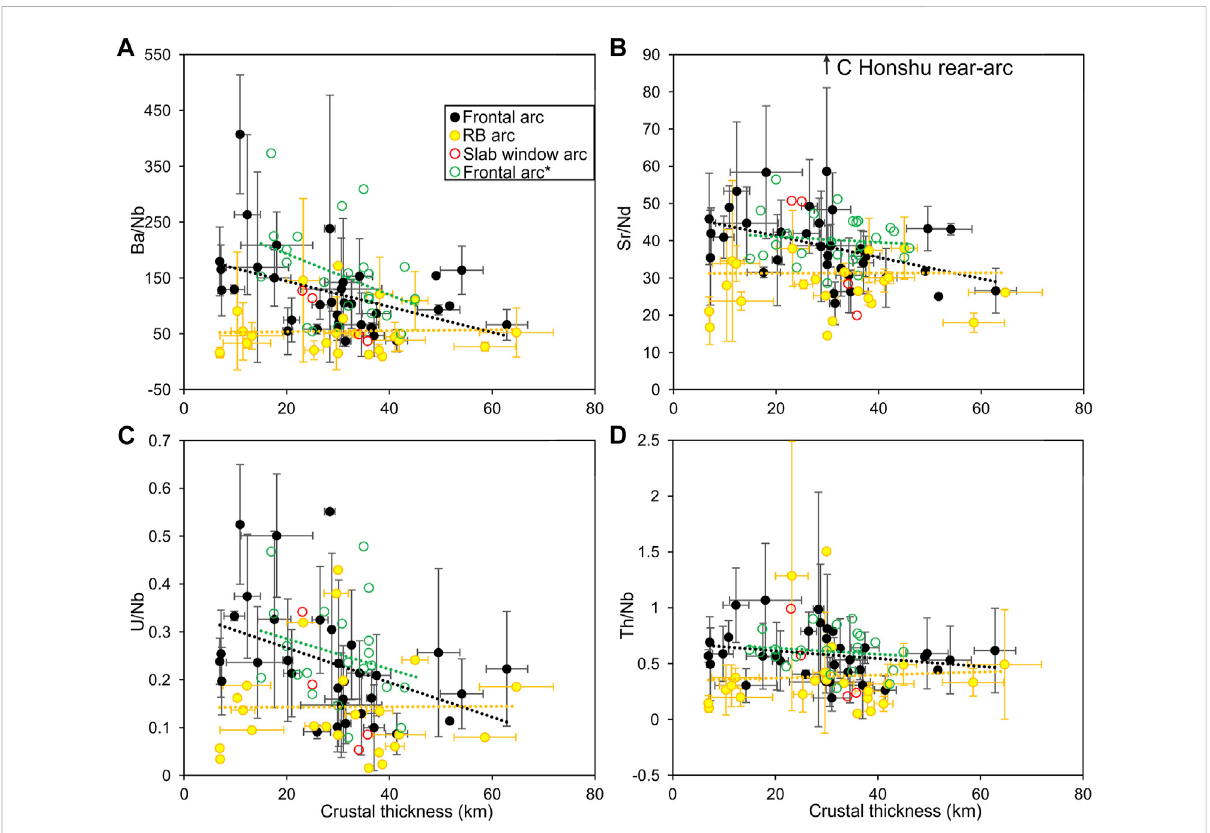
FIGURE 7 Comparisonoftraceelementratiosbetweenthefrontalarcandrear-/back-arcsections.Crustalthicknessvs. (A) Ba/Nb, (B) Sr/Ndand (C) U/Nb. Lower Ba/Nb, Sr/Nd, and U/Nb indicate the rear-/back-arc sections are less affected by aqueous fl uids compared with the frontal arc sections. (D) Crustal thickness vs. Th/Nb. Lower Th/Nb indicates the rear-/back-arc sections are less affected by sediment